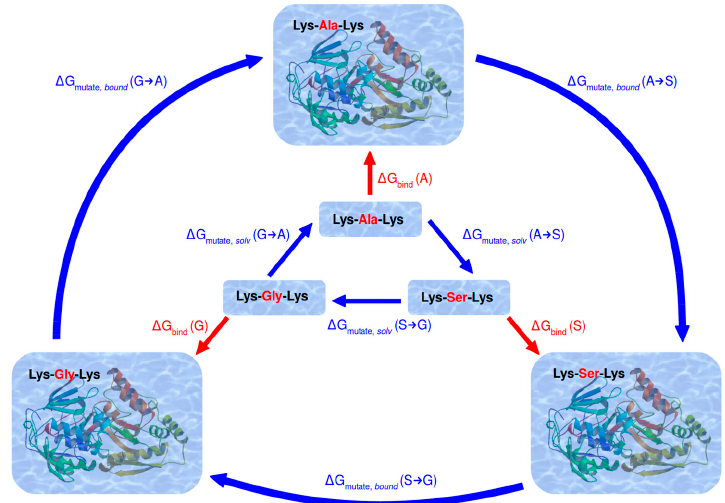
Figure 2. Thermodynamic cycle constructed between the three investigated ligands of OppA to calculate their relative binding free energy. Physical states and processes are denoted in red, whereas alchemical processes along unphysical intermediate states are denoted in blue.